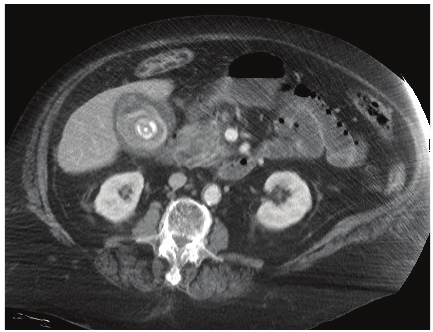
Figure 2: Axial CT image demonstrating gallbladder wall thicken- ing, mucosal hyperenhancement, and a calcified